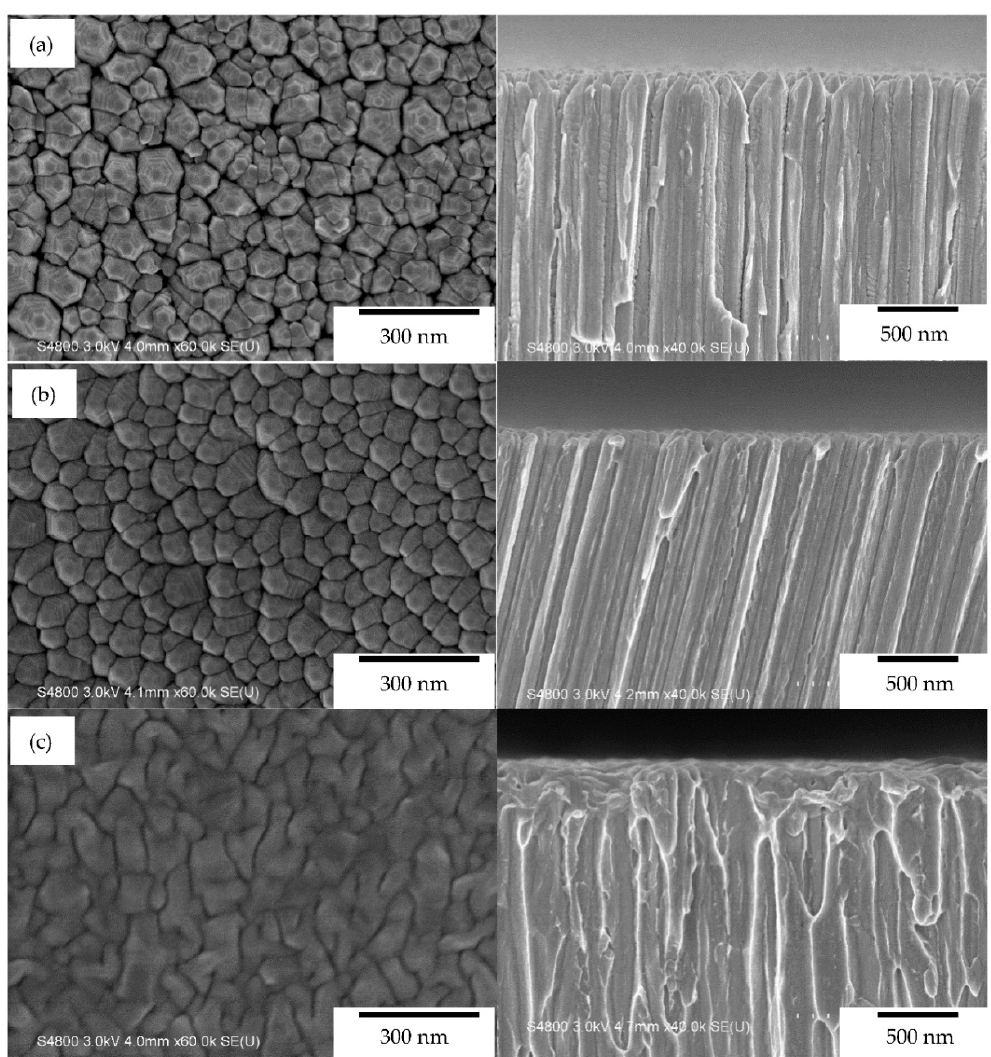
Figure 3. Top (left side) and cross-sectional (right side) SEM SE micrographs of Zr films deposited with the target pulse width of ( a ) 60 μ s, ( b ) 200 μ s, and ( c ) 400 μ s, at the argon pressure of 1.2 Pa on the grounded (substrate bias 0 V) silicon wafer chips.